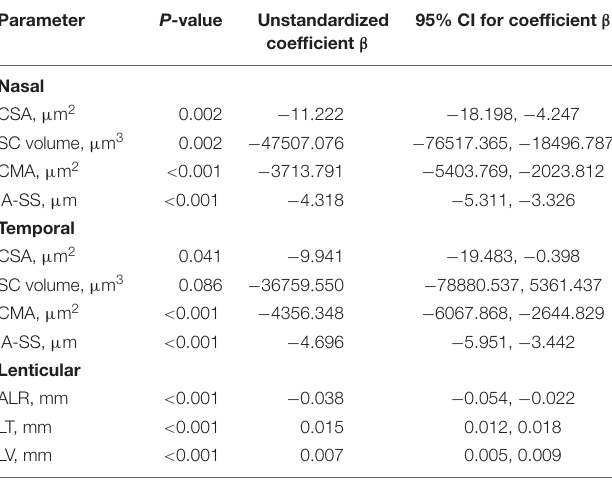
TABLE 3 | Correlations between nasal, temporal, and lenticular parameters and age with adjustments for axial length and